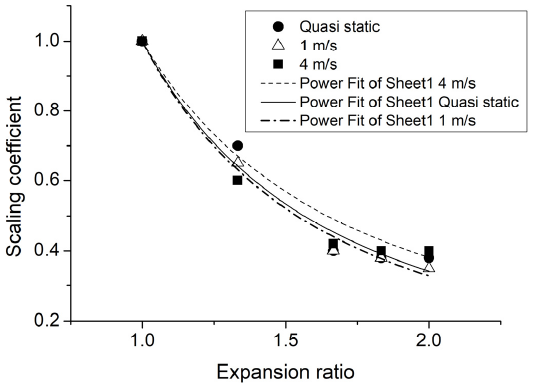
Figure 4. Coefficient for scaling the properties of the compact grade to obtain those of the expanded material as a function of the expansion ratio.